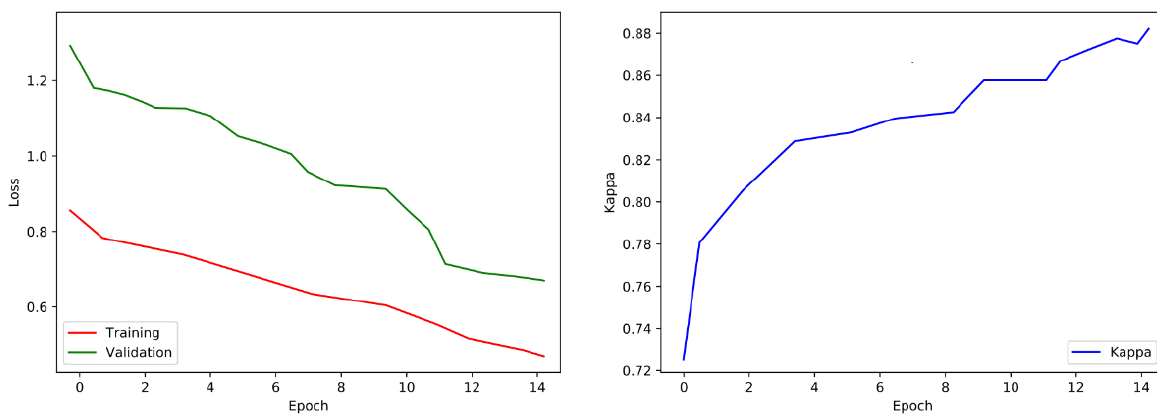
Figure 13. Validation loss and training visualization after fine-tuning.